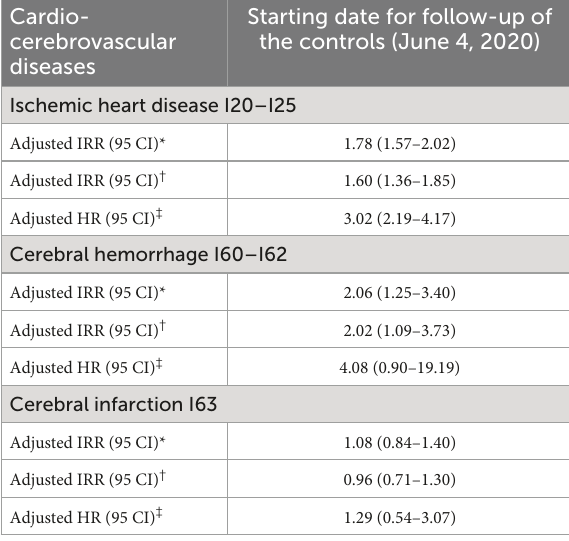
TABLE 2 Results of sensitivity analyses (log-link Poisson regression and Cox proportional hazard regression). Cardio-